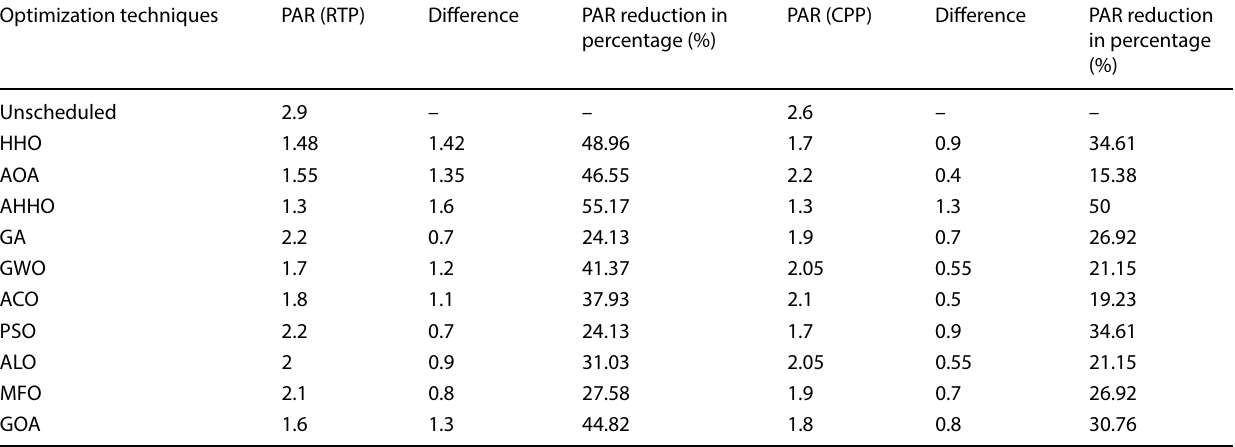
Table 3 PAR comparison with the unscheduled scheme Optimization